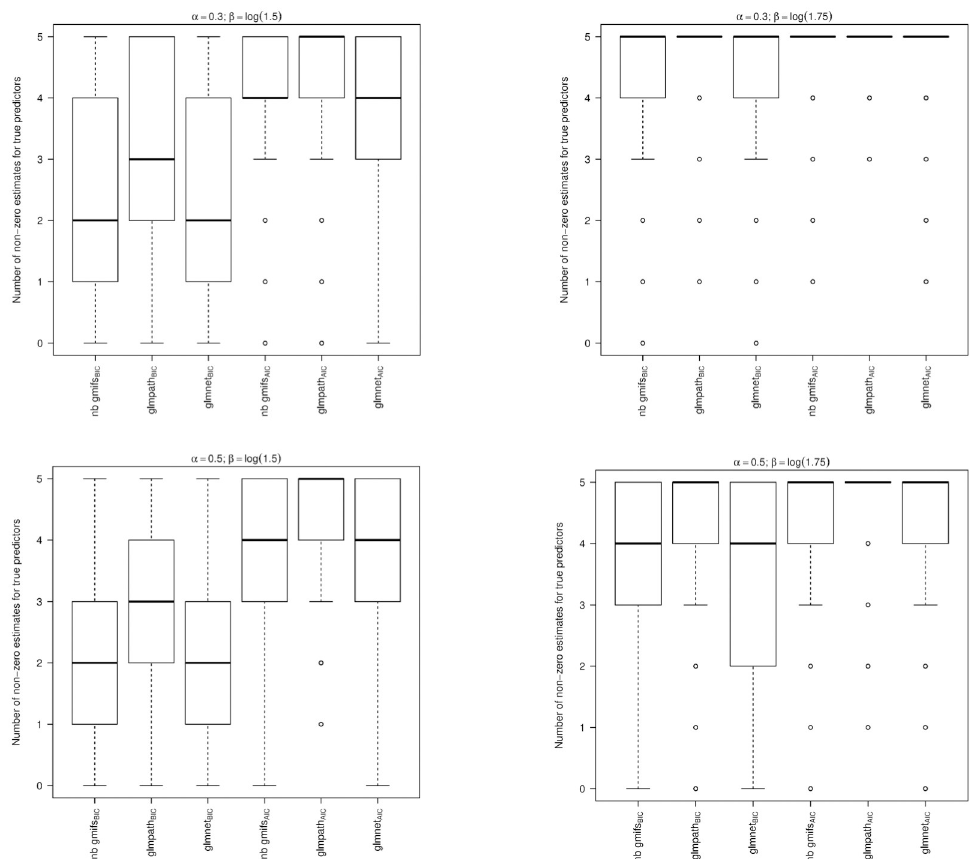
Fig 3. For each modeling method, number of true predictors that had a non-zero coefficient estimate (Oracle = 5). A: α = 0.3; β = ± log(1.5). B: α = 0.3; β = ± log(1.75). C: α = 0.5; β = ± log(1.5). D: α = 0.5; β = ±